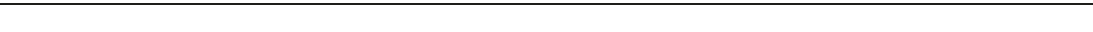
Fig. 2 No bias toward long genes is detected in MECP2 human datasets. a RNA-seq analysis of isogenic human Rett syndrome in vitro models. Overlap plots were used to compare WT and KO samples, where the top half of each subgraph shows the comparison of gene expression between WT samples and other WT samples (blue line), and the comparison between RTT samples and WT samples (red line) in iPSC (left panel), neural progenitor cells or NPC (middle panel), and neurons (right panel). The bottom half of each subgraph is the P value from the two-sample t test between MUT/WT and WT/ WT. Bins with FDR < 0.05 are shown as a red dot. The red dotted line in the bottom of the subgraphs indicates the minimum − log 10 ( P value) that corresponds to a FDR (false discovery rate) < 0.05. The blue and red ribbons in correspond to one-half of one standard deviation of each bin for the comparison of WT/WT and MUT/WT, respectively. b Microarray analysis of human RTT brain samples compared to age-matched control for frontal cortex 29 . Comparison of gene expression trends vs. gene length in the pooled sample from 2- and 4-year-old patients (left panel; blue line) and the whole dataset (left panel; red line). Observed changes in gene expression vs. gene length in the sample from 5-year-old (right panel; green line) or 8-year-old RTT patient (right panel; purple line). c Microarray analysis of RTT human frontal cortex samples 31 compared to controls (left panel) and RTT human temporal cortex samples 31 compared to controls (right panel). d RNA-seq analysis from RTT human (female) frontal cortex samples compared to controls (left panel) and RTT human (male) frontal lobe sample compared to controls (right panel). The lines in a – d represent the fold-change in expression for genes binned according to gene length (bin size of 200 genes with shift size of 40 genes 6 ). Please refer to Table 1 for the total number of samples used for the comparison between two random sets of WT samples and between WT and RTT